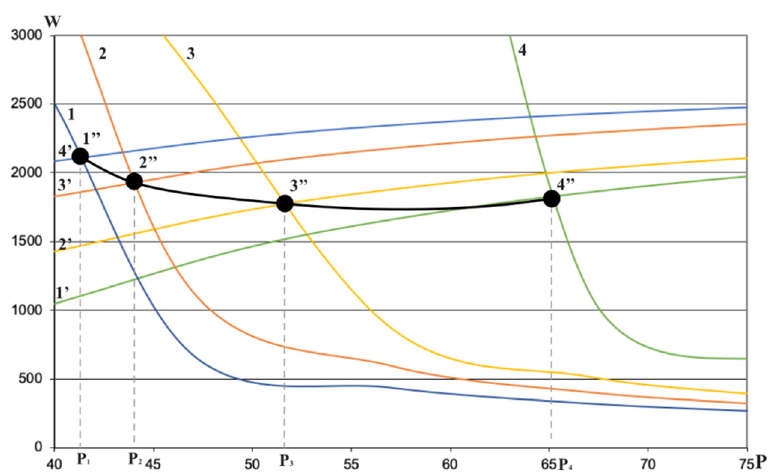
Figure 13. Pairing the characteristics of the rectification column and vacuum overhead system based on liquid ring vacuum pump curves 1, 2, 3, 4—the output of non-condensed gases from the rectification column condenser at different condensation isotherms (1’—28, 2’—32, 3’—35, 4’—40 °C). Curves 1’, 2’, 3’ and 4’—characteristic of LRVP. Curve 1’—temperature of the pumped-out gas tg = 40 °C, service liquid—t sl = 30 °C. Curve 2’ corresponds to t g = 35 °C and t sl = 25 °C, 3’—t g = 32 °C and t g = 20 °C, 4’—t g = 28 °C and t sl = 15 °C, respectively.